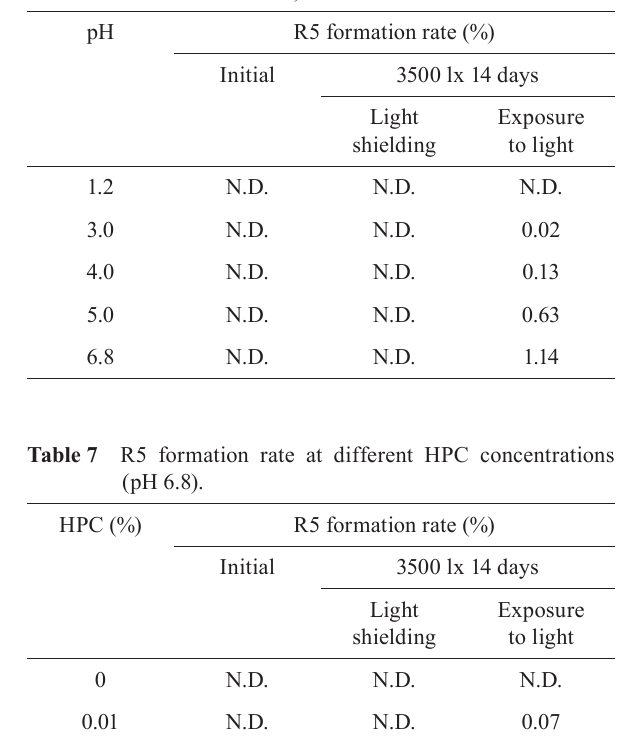
Table 6 R5 formation rate at different pH solutions (HPC